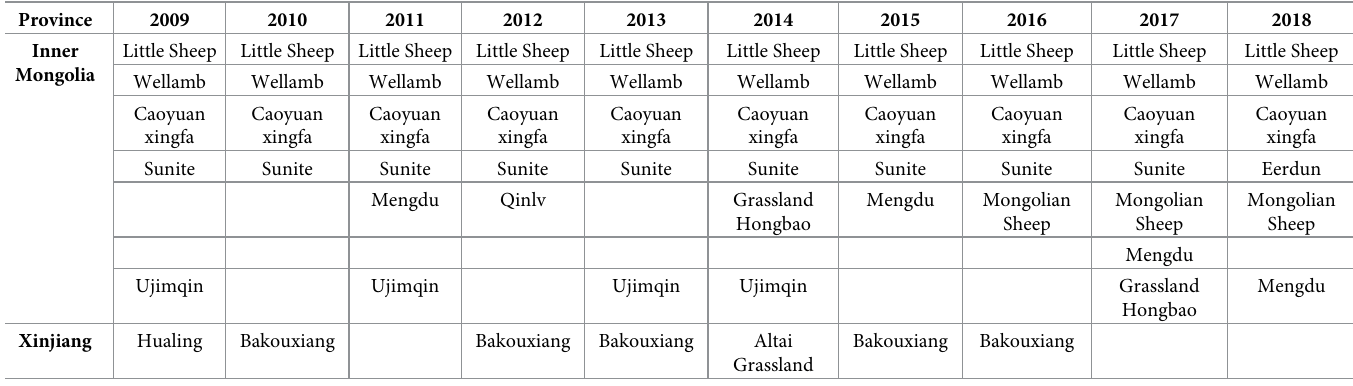
Table 7. The top 10 mutton brands favored by Chinese consumers (Inner Mongolia and Xinjiang),